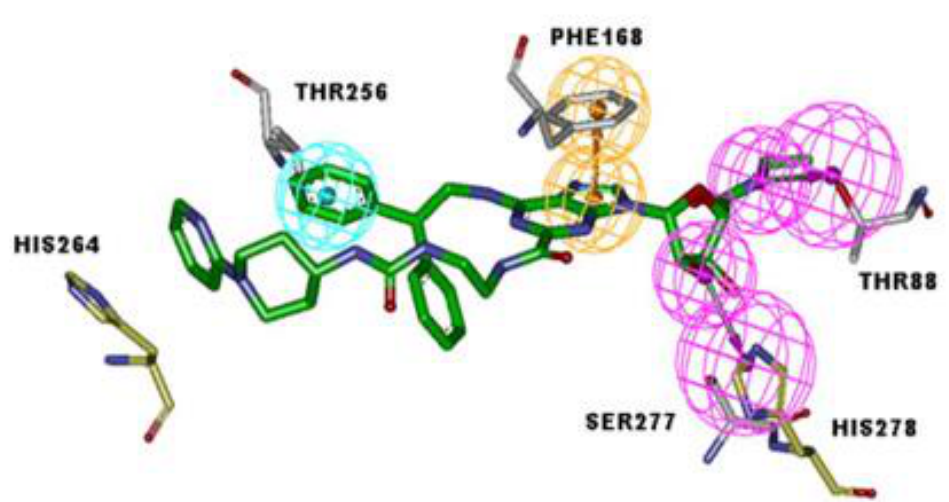
Figure 4. Pharmacophore model selected for the design of novel and potential A 2A AR agonists, obtained using the Discovery Studio software. In cyan is the sphere representing the hydrophobic group, in rose is the Hydrogen bonding donor and, in orange, the aromatic group.